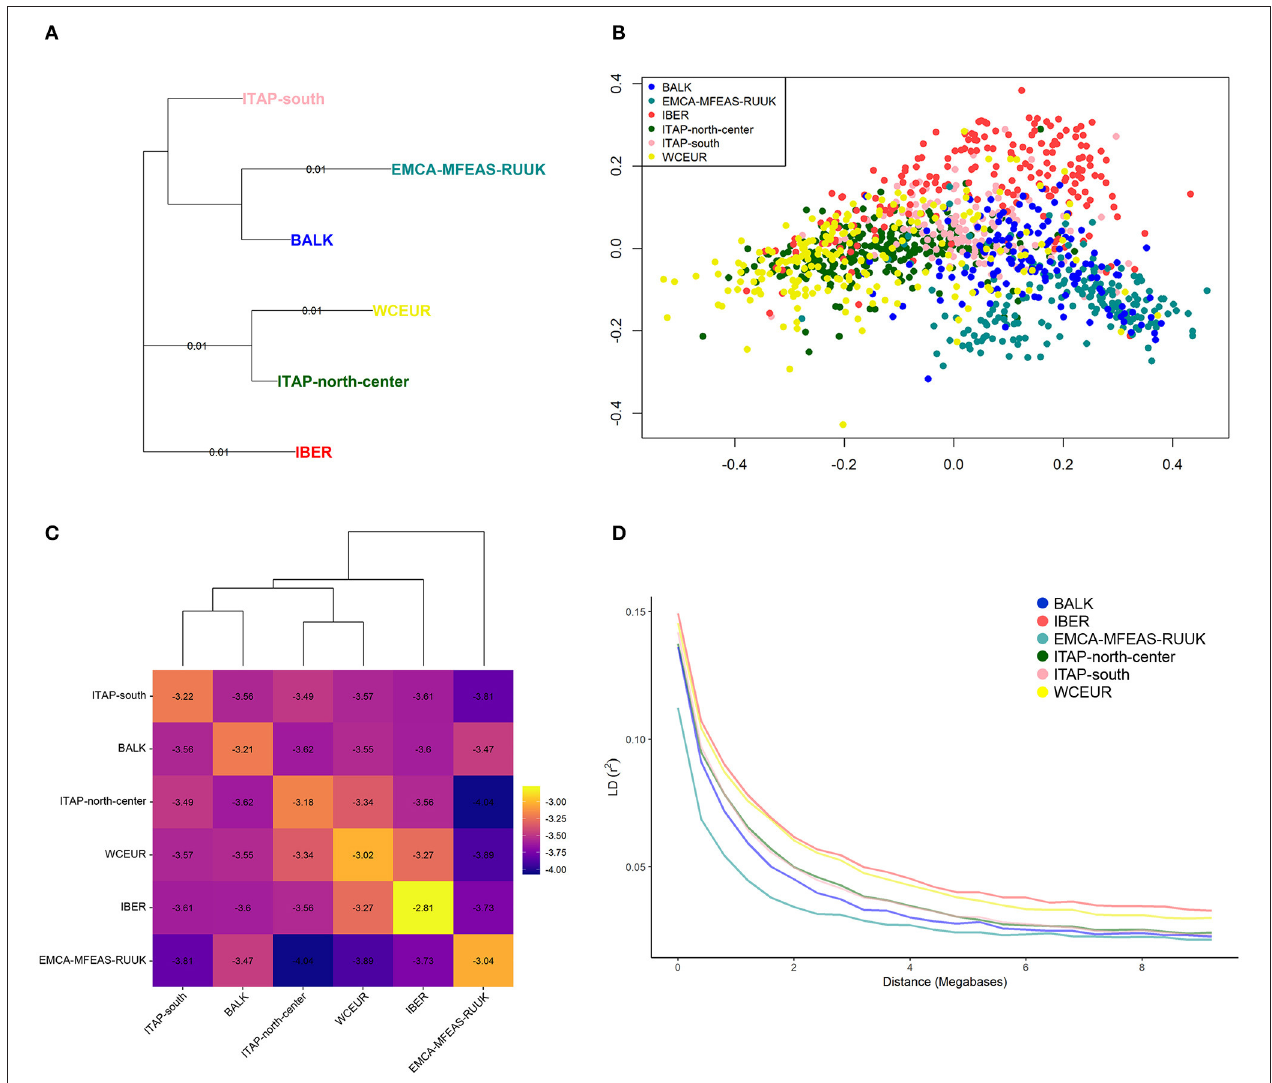
FIGURE 3 | (A) NJ-tree based on population pairwise Fst . Genetic distances were computed among populations (Table 1 and Supplementary Table 1) . (B) MDS analysis using IBD segments evaluated on 1,038 grapevine varieties, collected across Europe, Caucasus, Middle, and Far East. The varieties were highlighted based on their geographical origin (Table 1 and Supplementary Table 1) . (C) Heatmap of the log average proportion of genome shared IBD between a pair of individuals belonging to groups analyzed. Colors are described in the palette on the right; higher values (less negative, toward the yellow end of the color scale) indicate higher IBD sharing. Cluster obtained through the proportion of shared IBD was also visualized. (D) Decay of average LD ( r 2 ) over distance (Mb) in the six groups (Table 1) . NJ, neighbor-joining; fst, fixation index; MDS, multi-dimensional scaling; IBD, identity by descent; LD, linkage disequilibrium.